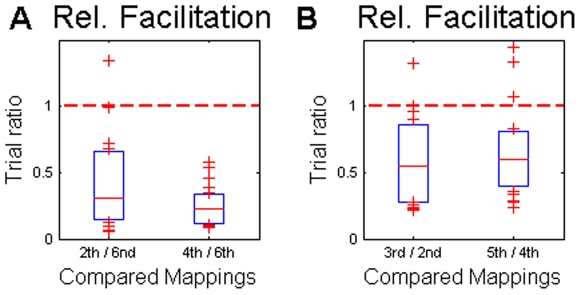
Relative facilitation of learning.(A) Mappings with structural constraints were learned much faster than the random mapping. (B) Learning the third (fifth) mapping was facilitated in both groups compared to learning the second (fourth) mapping. Shown are the medians and the lower and upper quartiles of the trial ratios of all subjects and the average has been taken over both groups.